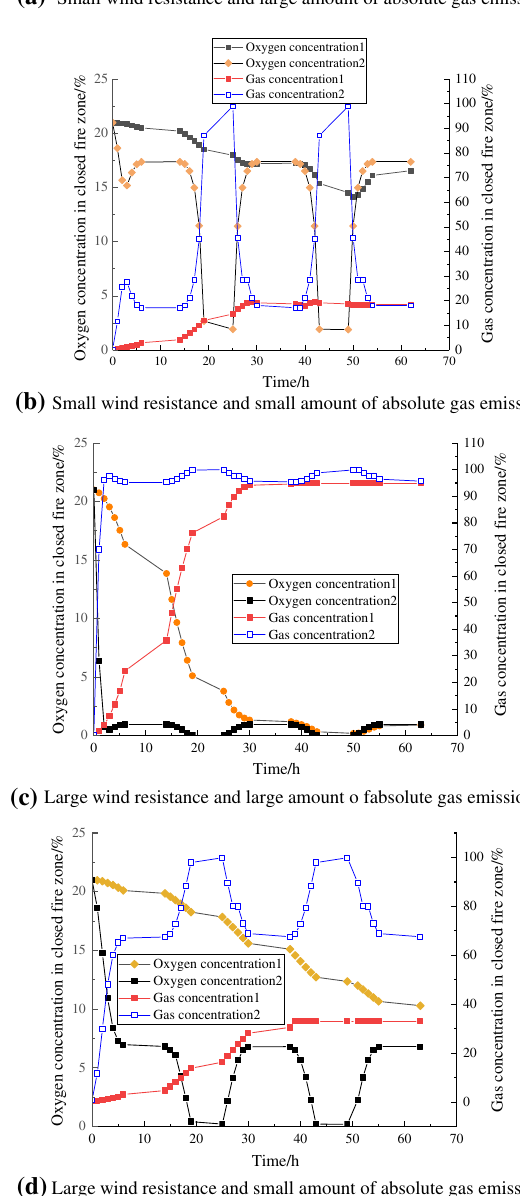
(a) Small wind resistance and large amount of absolute gas emission